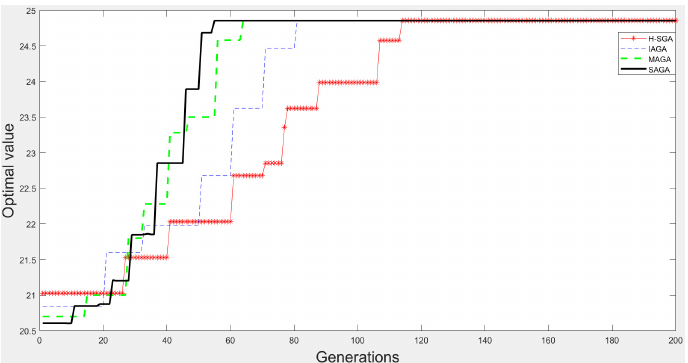
Figure 9. The experimental results on function F 1 .